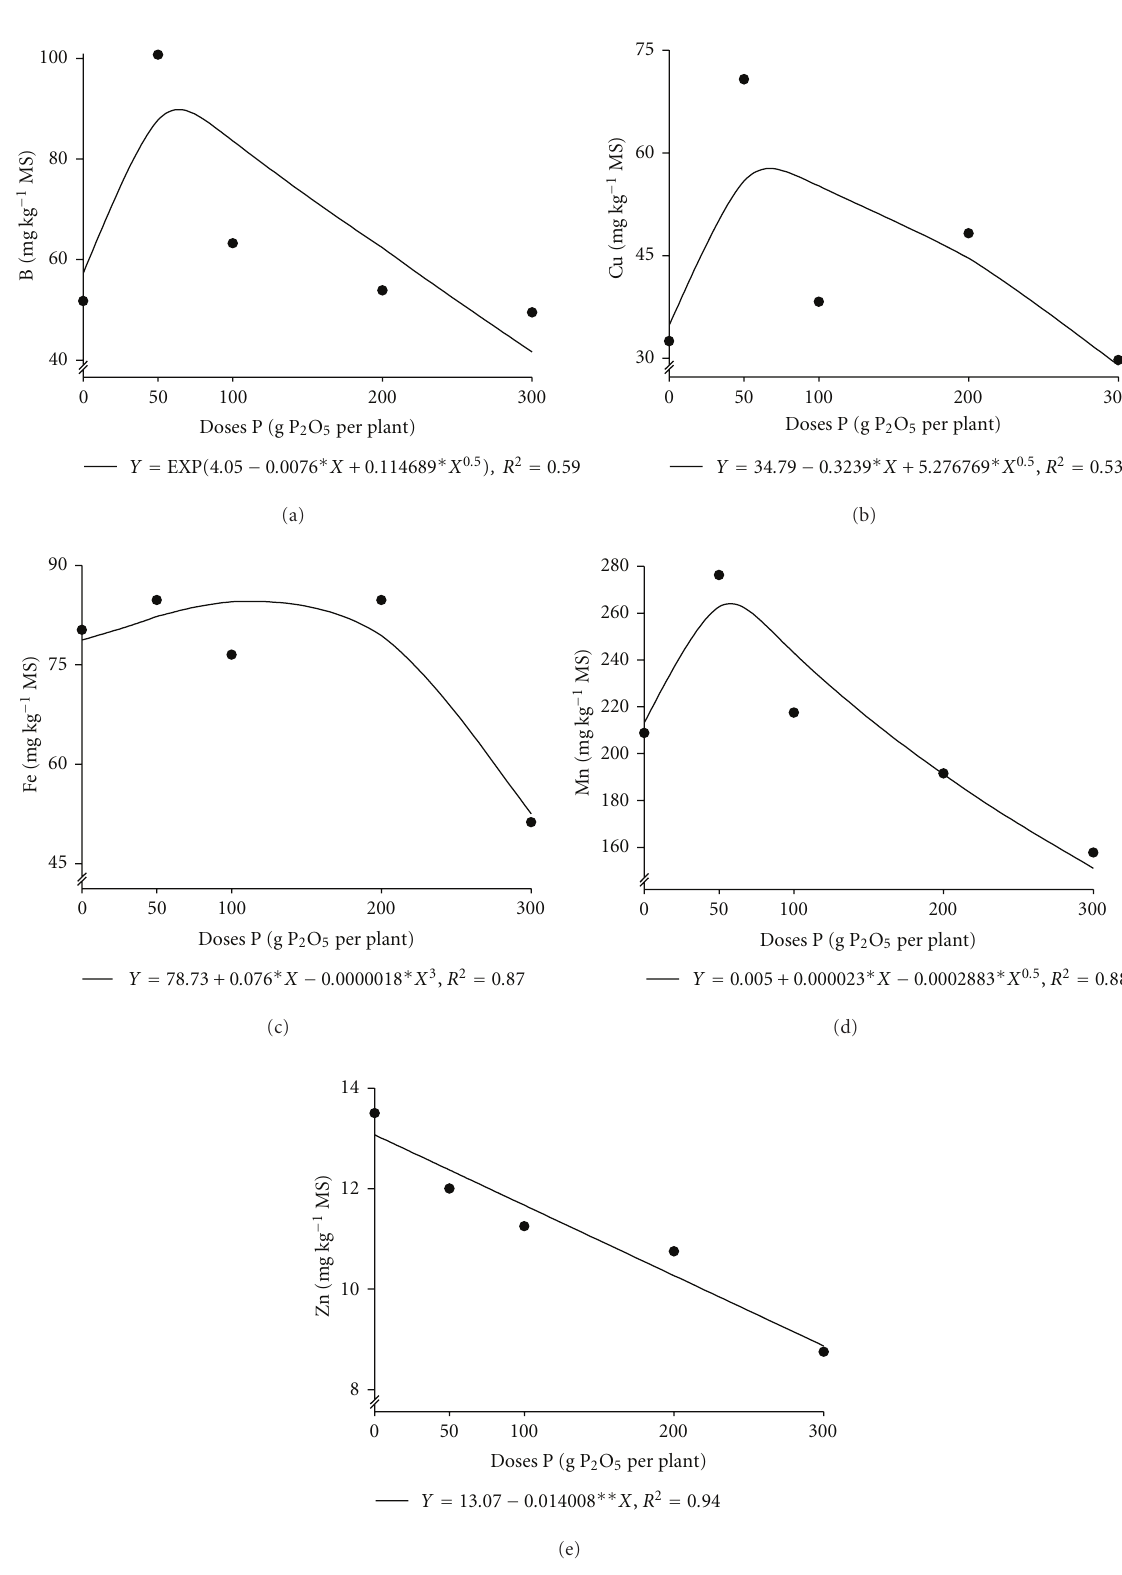
Figure 3: E ff ect of phosphorus applied at planting on lychee plants foliar levels of B (a), Cu (b), Fe (c), Mn (d), and Zn (e). ∗∗ Significant P < 0 . 01 and ∗ significant P < 0 .